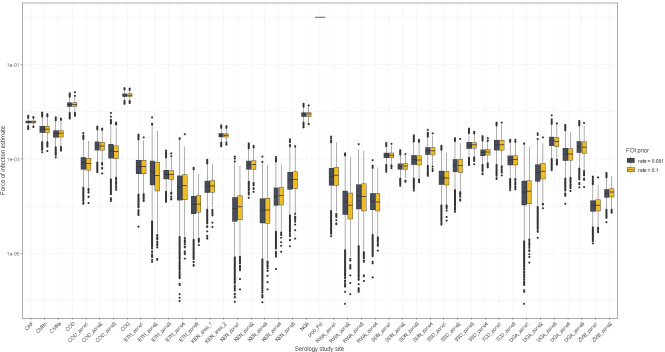
Comparison of force of infection estimates for the serological study sites using two prior formulations.The first, used throughout the manuscript, is exponential with rate = 0.001. The comparitor is exponential with rate = 0.1.